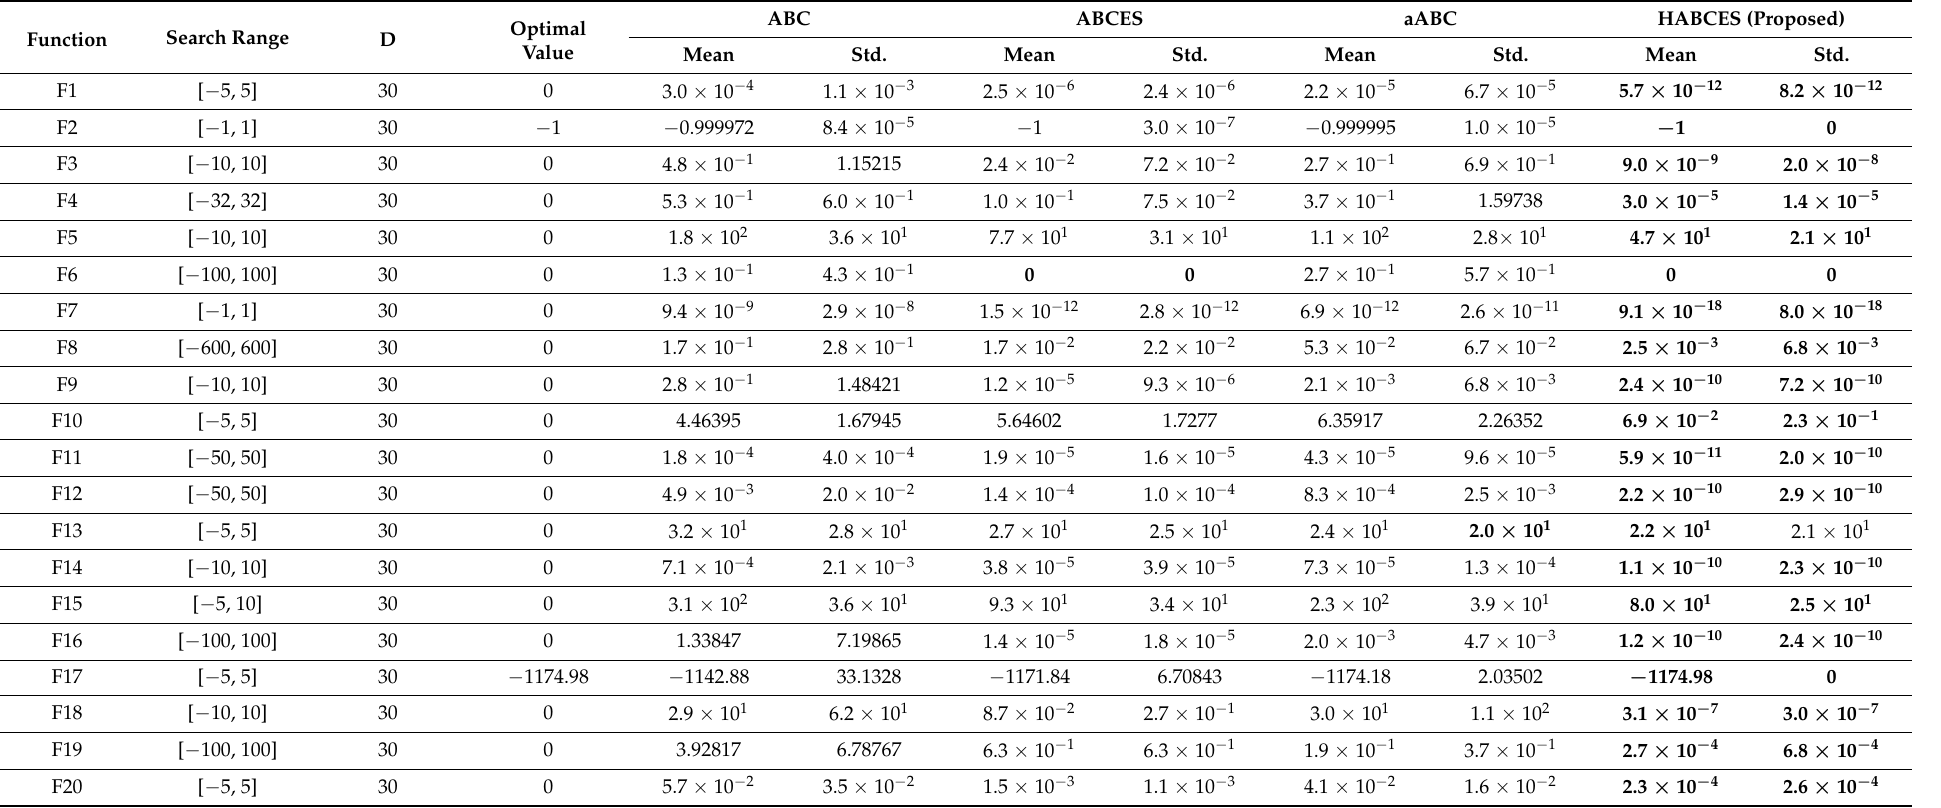
Table 2. Comparison of the results of the ABC, aABC, ABCES and HABCES algorithms for solving high-dimensional global optimization